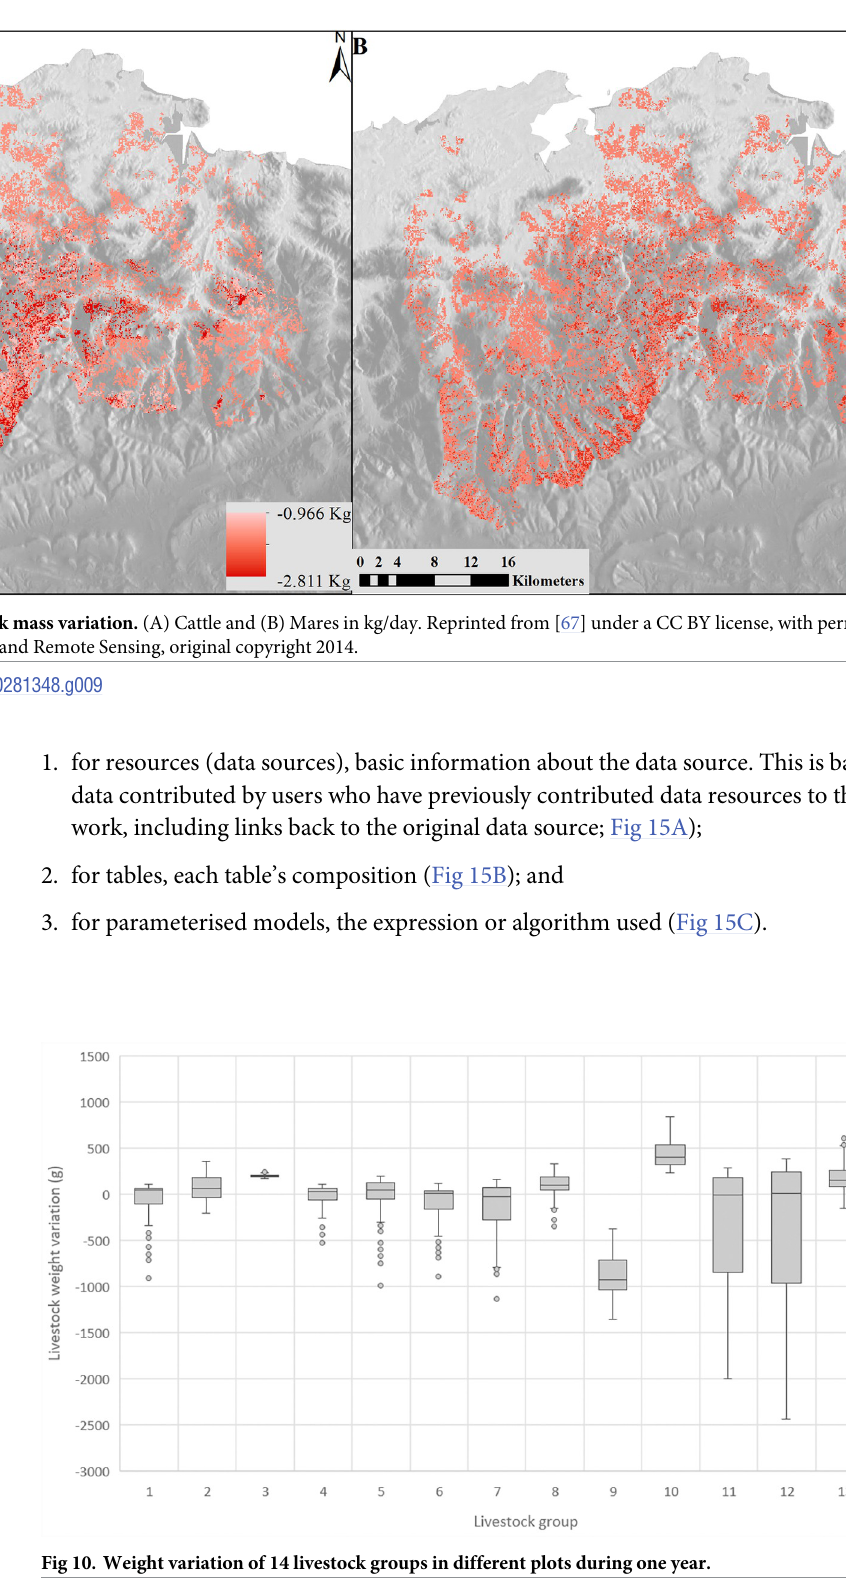
Fig 10. Weight variation of 14 livestock groups in different plots during one